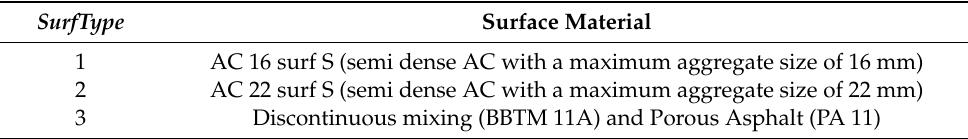
Table 10. Considered material categories for variable SurfType .